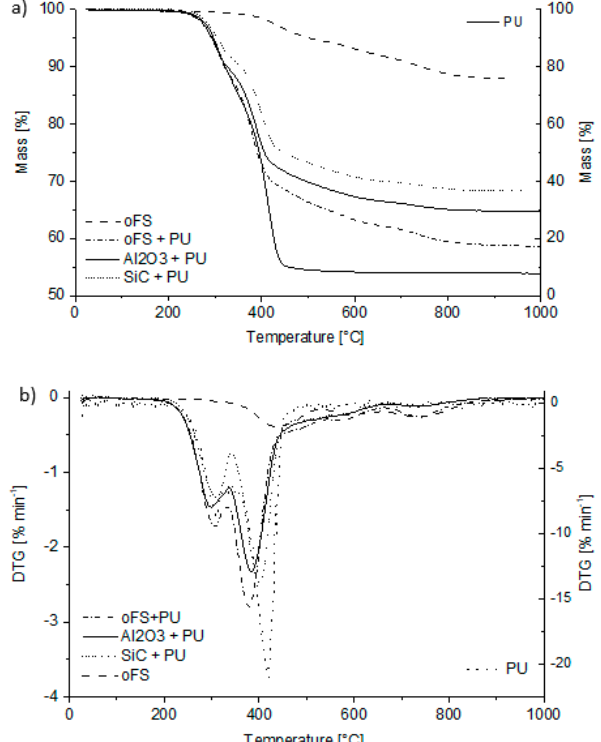
Figure 6. ( a ) Thermogravimetric analysis of the preceramic coating material without fillers (oFS), of the polyurethane foam template (PU) and of the crosslinked coated foams with (Al 2 O 3 + PU, SiC + PU) and without fillers (oFS + PU) including the polyurethane template; ( b ) Differential thermogravimetric (DTG)-signal of the thermogravimetric signals.